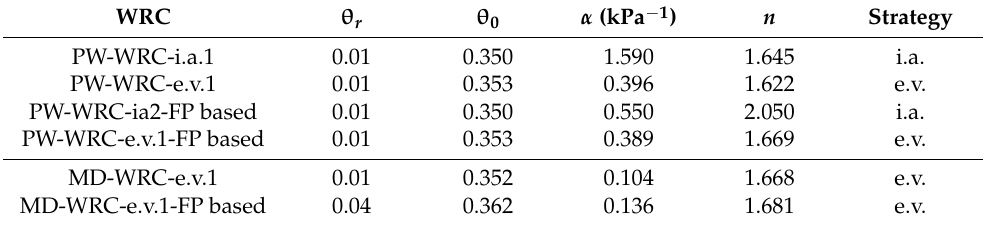
Table 3. Van Genuchten model shape factor of WRC, from different strategy/scale of investigation, hydraulic path: i.a. = inverse analysis/physical modeling; e.v. = element volume, on specimen measurement; FP = filter paper technique; PW = primary wetting; MD = main drying. WRC θ r θ 0 α (kPa − 1 ) n WRC θ r θ 0 α (kPa − 1 ) n Strategy PW-WRC-i.a.1 0.01 PW-WRC-e.v.1 0.01 PW-WRC-ia2-FP based MD-WRC-e.v.1